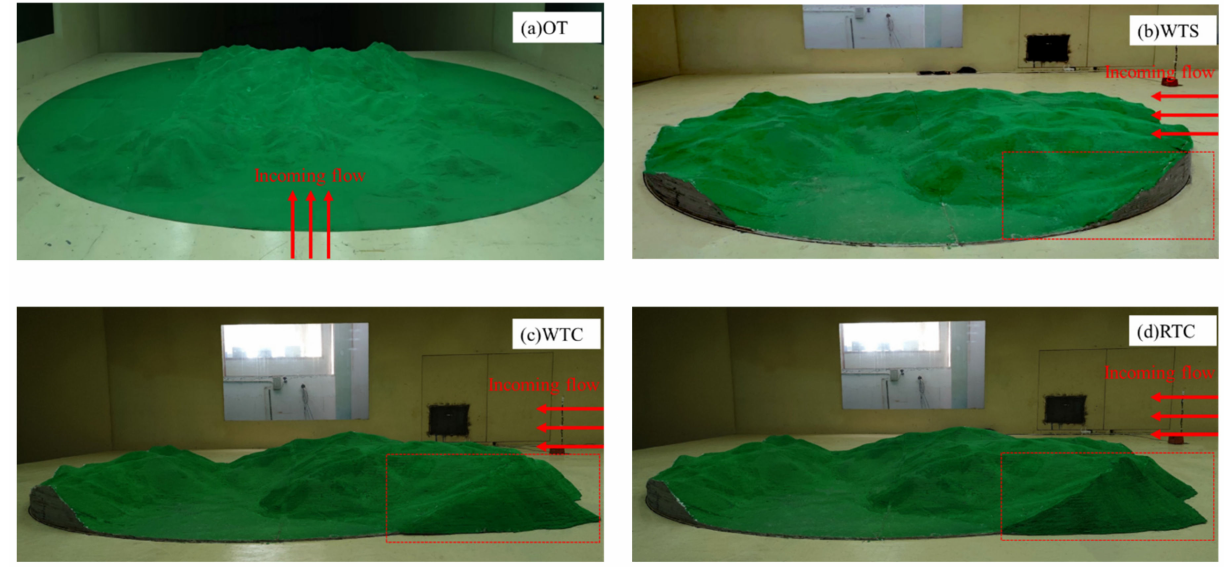
Figure 3. The test model at wind tunnel: ( a ) OT; ( b ) WTS; ( c ) WTC; ( d )